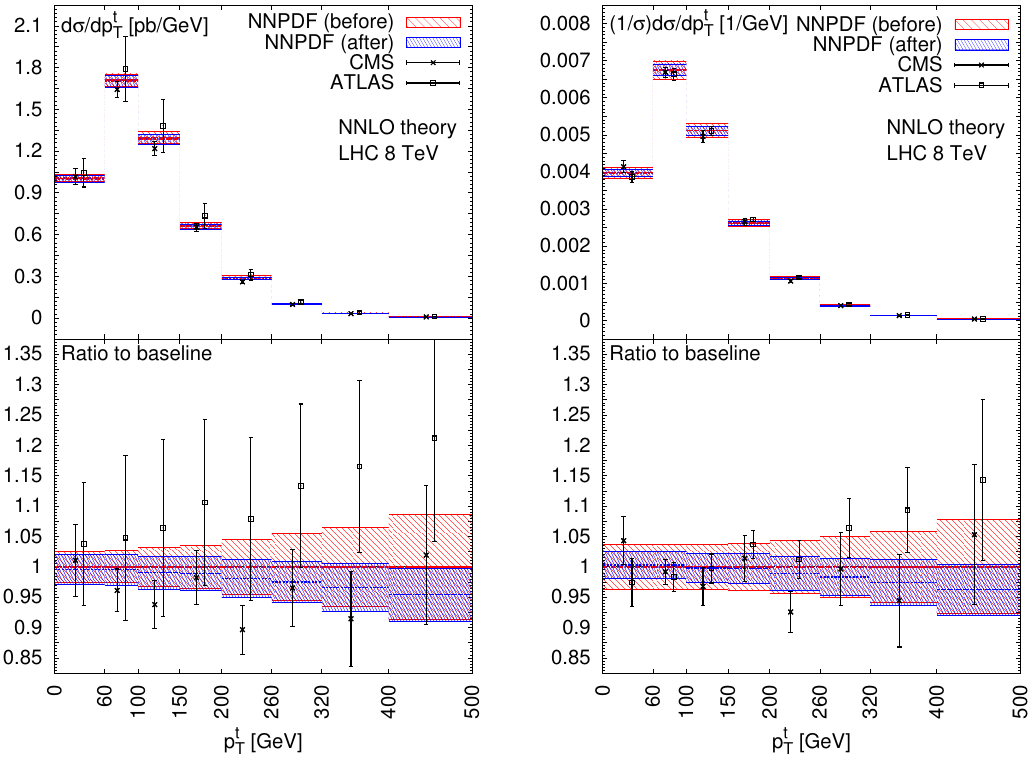
Figure 20 . Same as (cid:12)gure 19 for the top quark pair p t